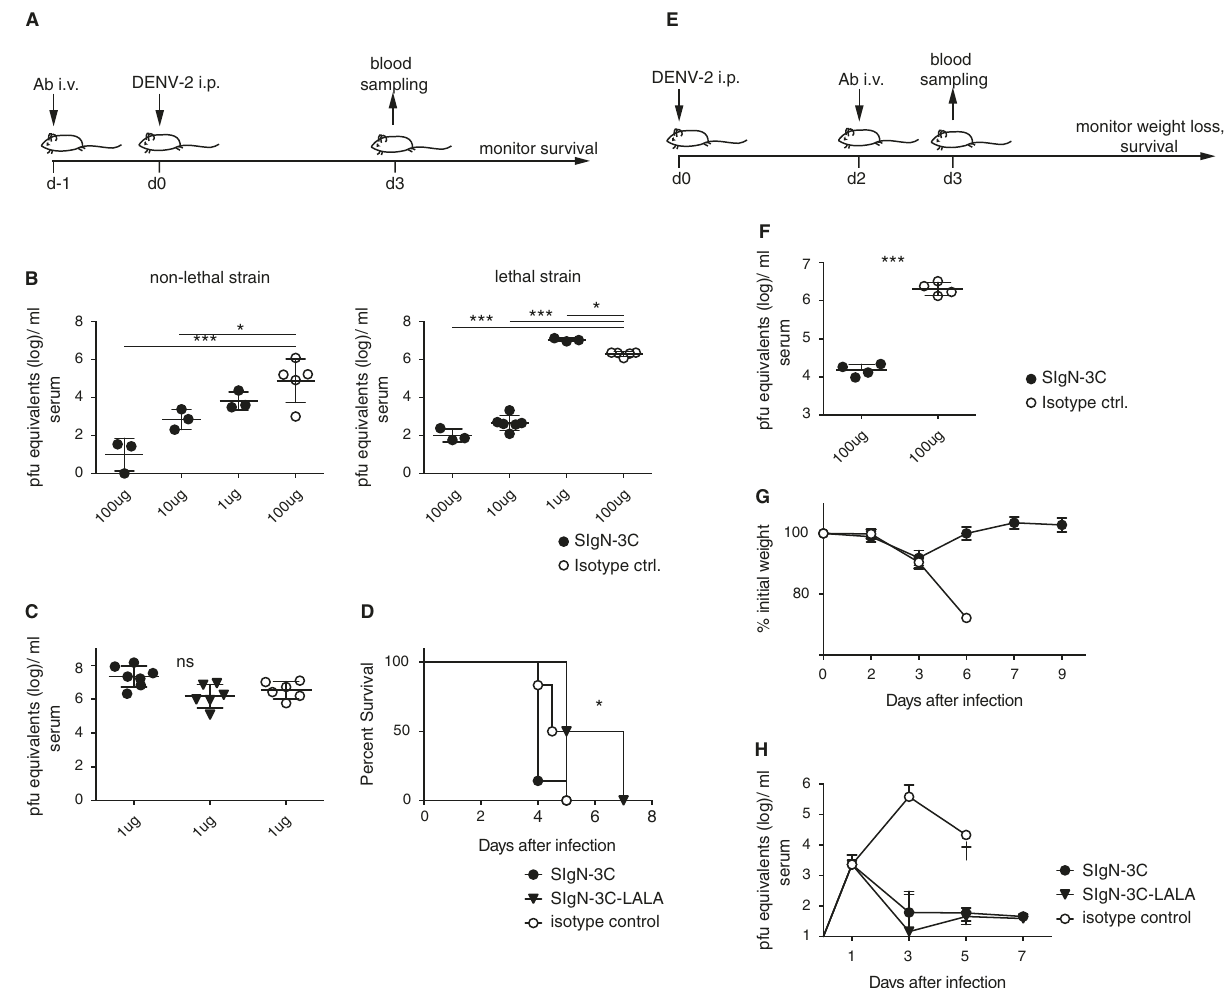
Fig. 2 SIgN-3C in vivo ef fi cacy against DENV-2 infection. a Scheme for the prophylactic treatment of mice. b Viremia in prophylactically treated AG129 mice at day 3 after challenge with non-lethal DENV-2 strain TSV01 and with lethal DENV-2 strain D2Y98P. One way anova *: p < 0.05, ***: p < 0.001. c Viremia at day 3 after challenge in mice treated prophylactically with 1 μ g of SIgN-3C, SIgN-3C-LALA or an isotype control. d Survival of the mice shown in c ; Log rank test *: p = 0.002 for the comparison between SIgN-3C and SIgN-3C-LALA. An adjusted p value of < 0.02 was considered signi fi cant. For c and d data are pooled from two independent experiments with three mice per group each. e Scheme for the therapeutic treatment of AG129 mice. f Viremia at day 3 after challenge with DENV-2 D2Y98P. student ’ s t test ***: p < 0.0001. g Weight loss in IFNAR mice treated therapeutically with SIgN-3C or isotype control. Mice in the isotype control group all had to be euthanized by day 6. h Viremia measured at day 1, 3, 5 and 7 after infection with DENV-2 D2Y98P in AG129 mice treated therapeutically with 100 μ g SIgN-3C, SIgN- 3C-LALA or an isotype control. Mice in the isotype control group all had to be euthanized by day 5. Symbols represent means ± SD, n = 4 per group. b , c and f . Each symbol represents one mouse and means ± SD are shown. One way anova test was performed for experiments with more than two groups or a student ’ s t test for experiments with two groups of